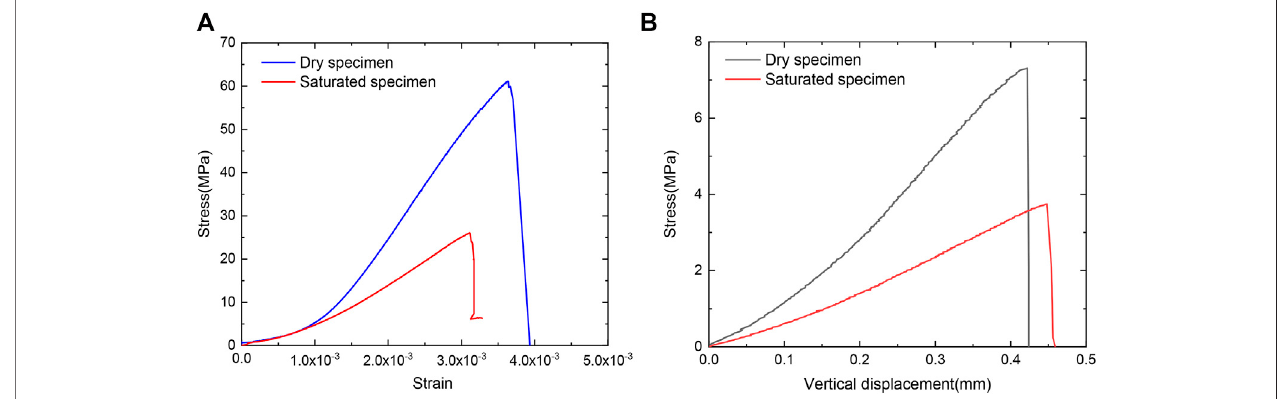
Frontiers in Earth Science |